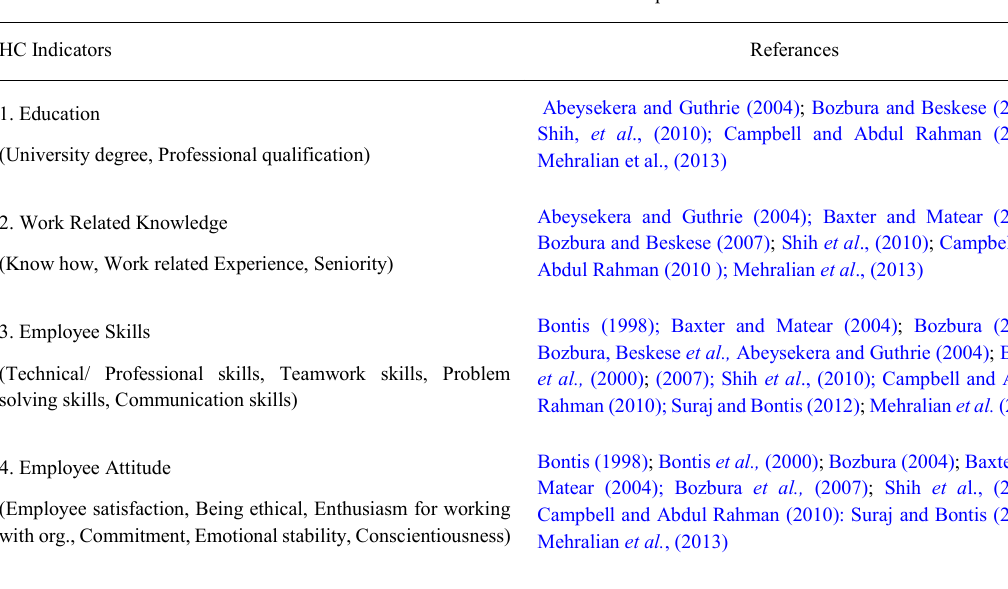
Table 1: Indicators of human